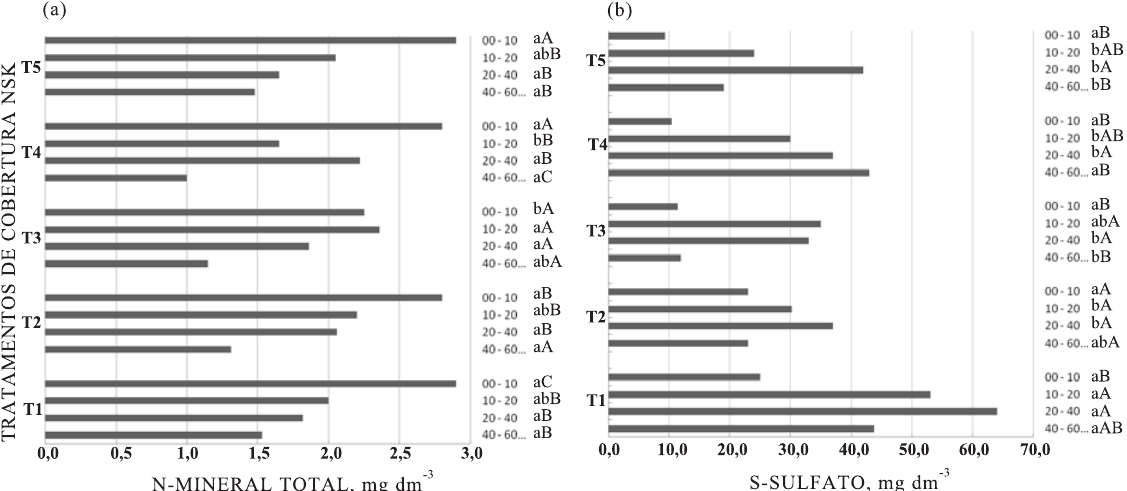
Figura 4. Distribuição em profundidade até 60 cm do N-mineral (a) e S-sulfato (b), 30 dias após efetuada a adubação de cobertura das fontes NSK de mistura de grânulos, na cultura de milho na safra 2005/2006. Uberlândia (MG). DMS (entre fontes) = 22,2; DMS (entre profundidades) = 20,8; CV (%) = 36,8; T1 = testemunha; T2 = U+Sa ; T3 = U+SA ; T4 = U+Gesso ; T5 = U+Gesso . Entre fontes, na mesma fa gr gr pó profundidade, as médias seguidas de letras minúsculas iguais não diferem estatisticamente a 0,05 pelo teste de Tukey. Entre profundidades, para cada fonte, as médias seguidas de letras maiúsculas desiguais diferem estatisticamente a 0,05 pelo teste de